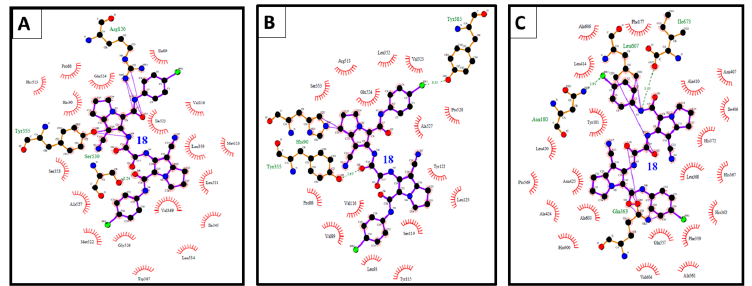
Figure 12. ( A ) The binding interactions of compound 18 into COX-1; ( B ) binding interactions of compound 18 into COX-2; and ( C ) binding interactions of compound 18 into 5-LOX illustrated by Ligplot.